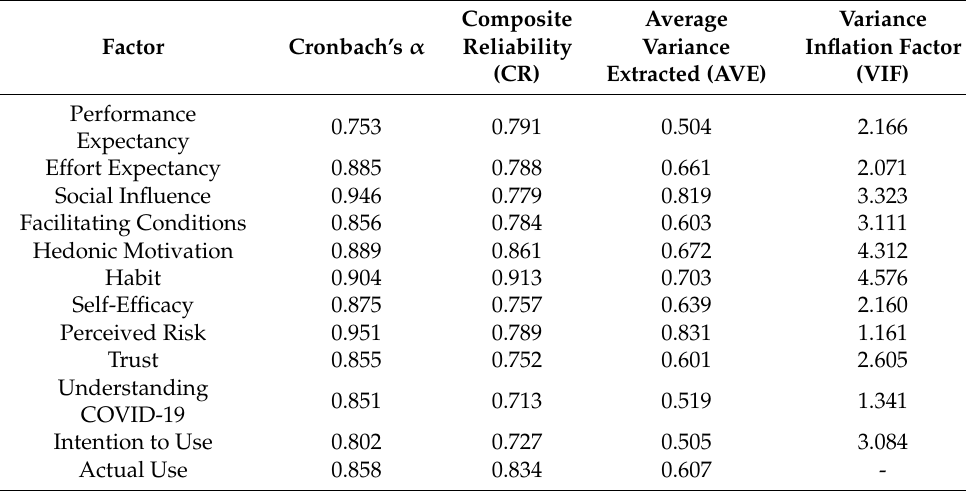
Table 5. Composite reliability and